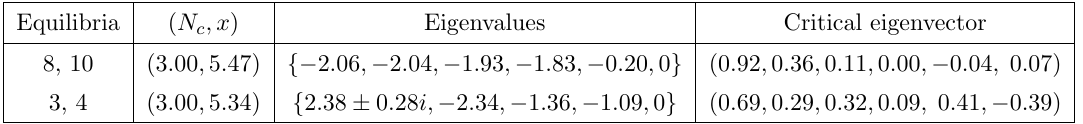
4 (3.3) shown in (cid:12)gure 20.